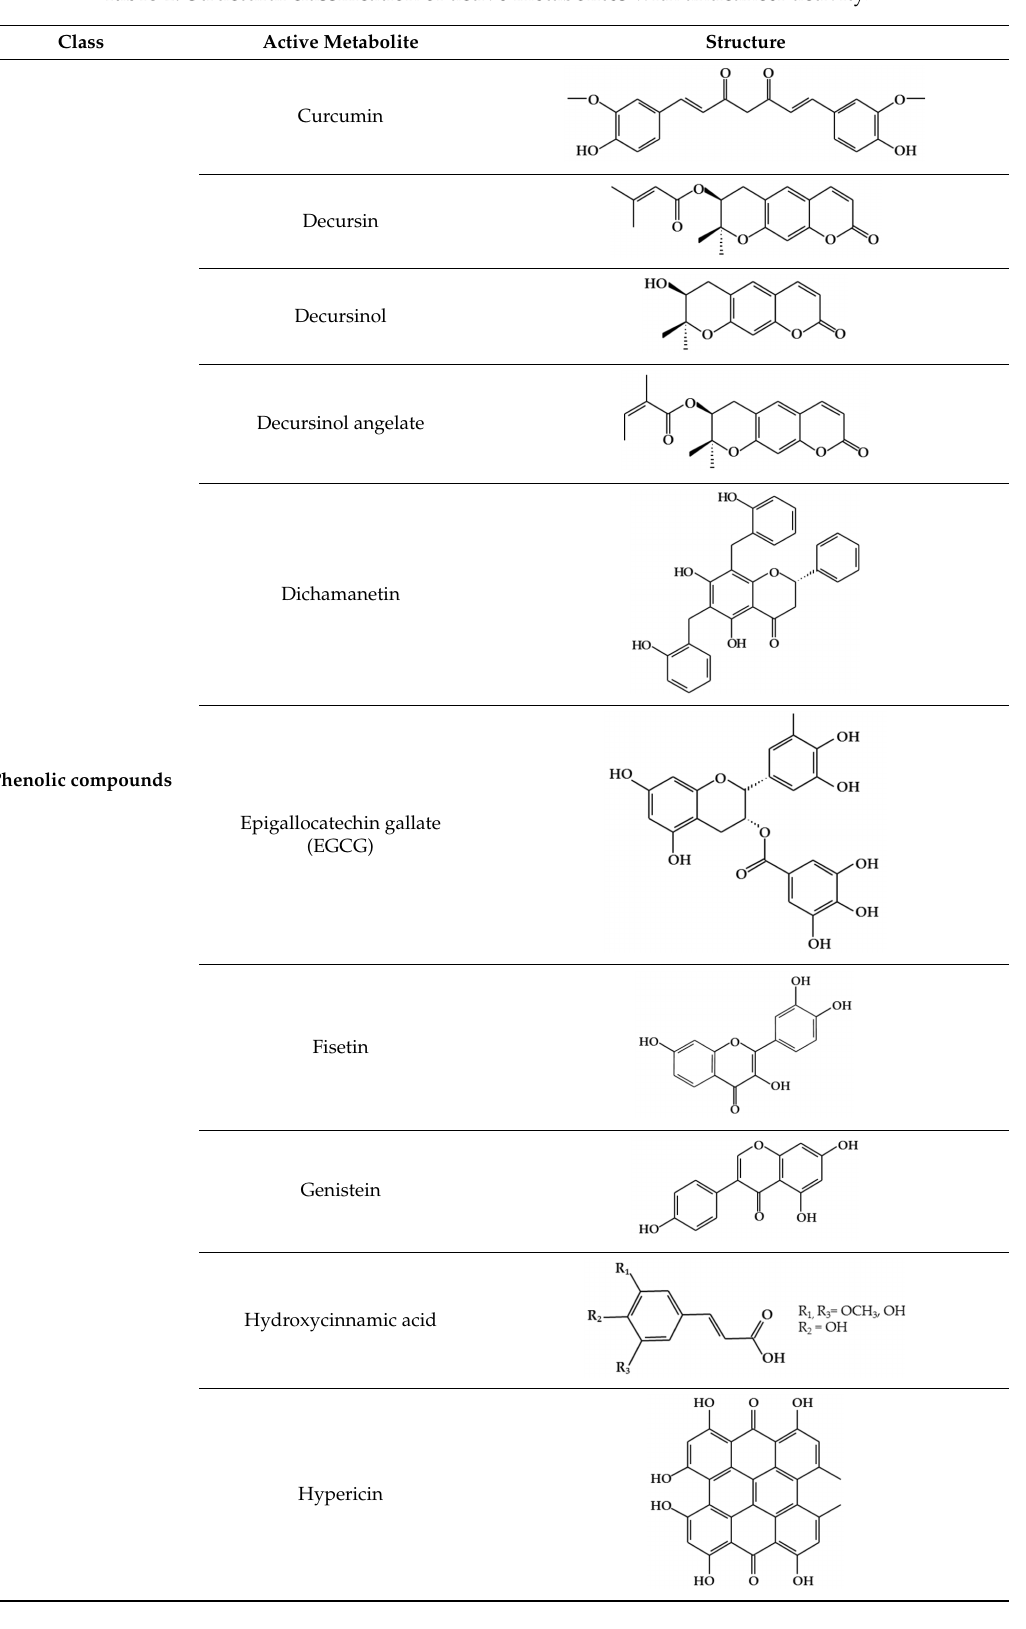
Table 1. Structural classification of active metabolites with anticancer